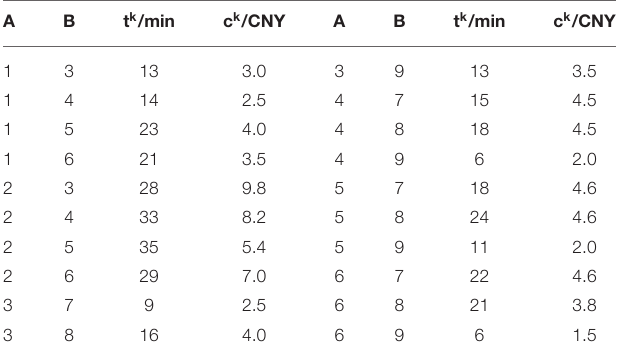
TABLE 2 | Information of transportation time and unit transportation cost between stations.